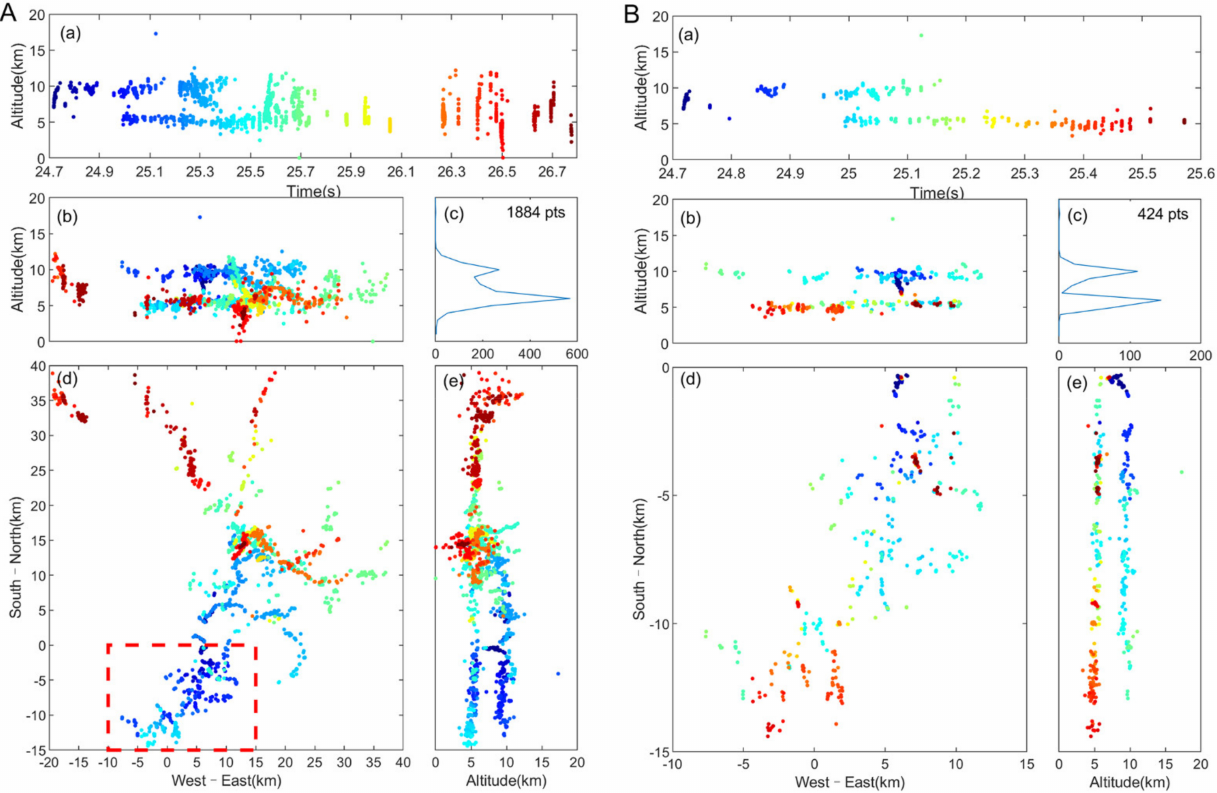
Figure 11. ( A ) The positioning results of the lightning process at 16:26 on 15 August 2015 under 5 dB SNR signals by the new method and ( B ) the partial developments. In each subgraph, ( a ) height–time plots; ( b ) north–south vertical projection; ( c ) height distribution of radiation events; ( d ) plan view; and ( e ) east–west vertical projection of lightning radiation